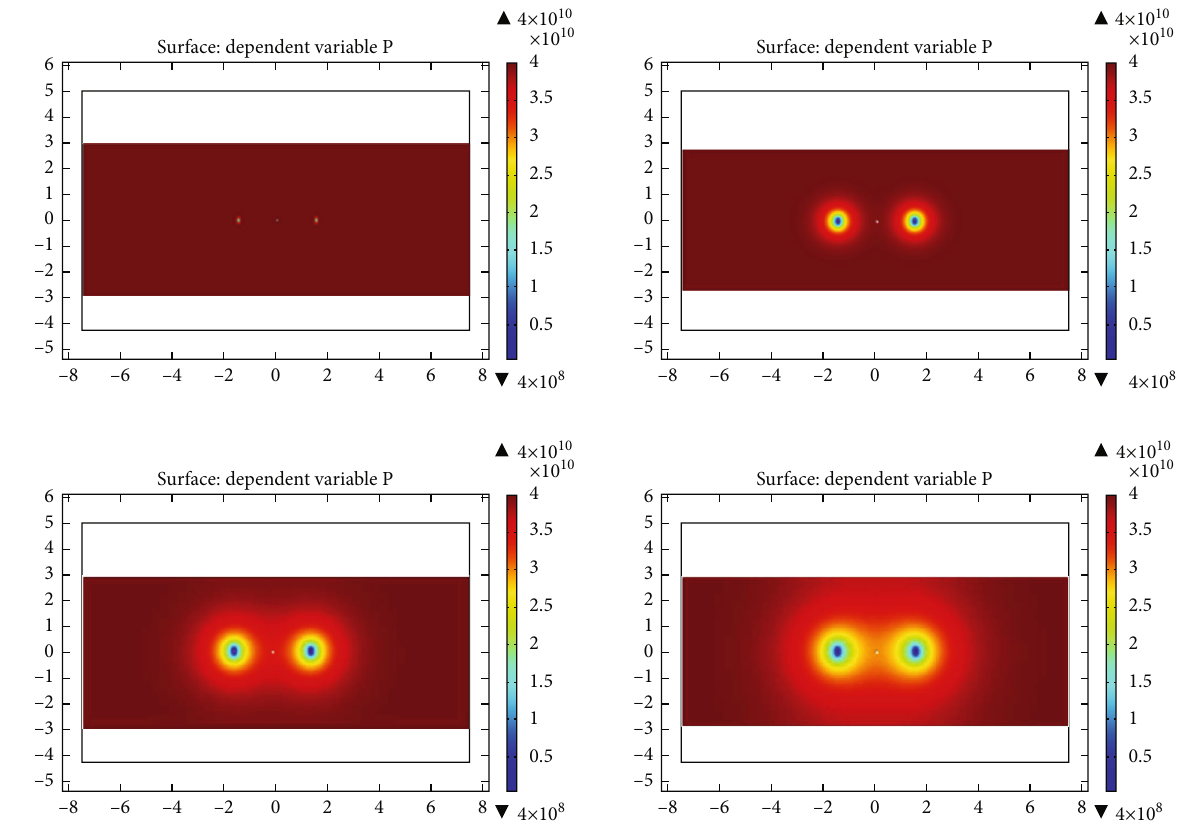
Figure 6: Gas pressure distribution chart of single-hole